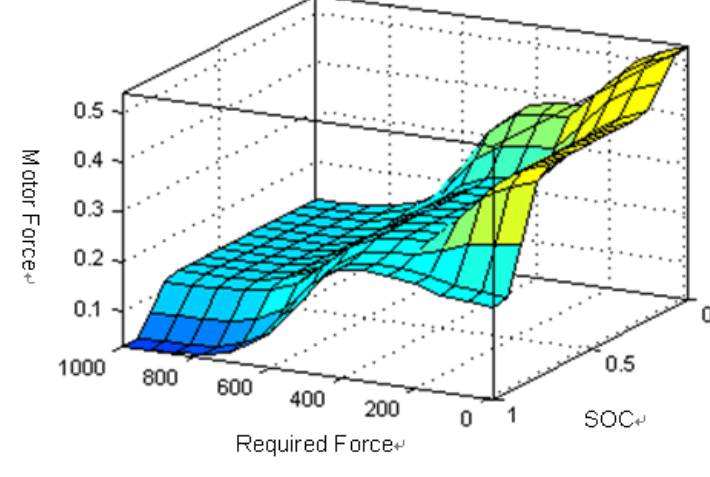
Figure 12. Relationships between driver’s braking force command, battery SOC and motor force.